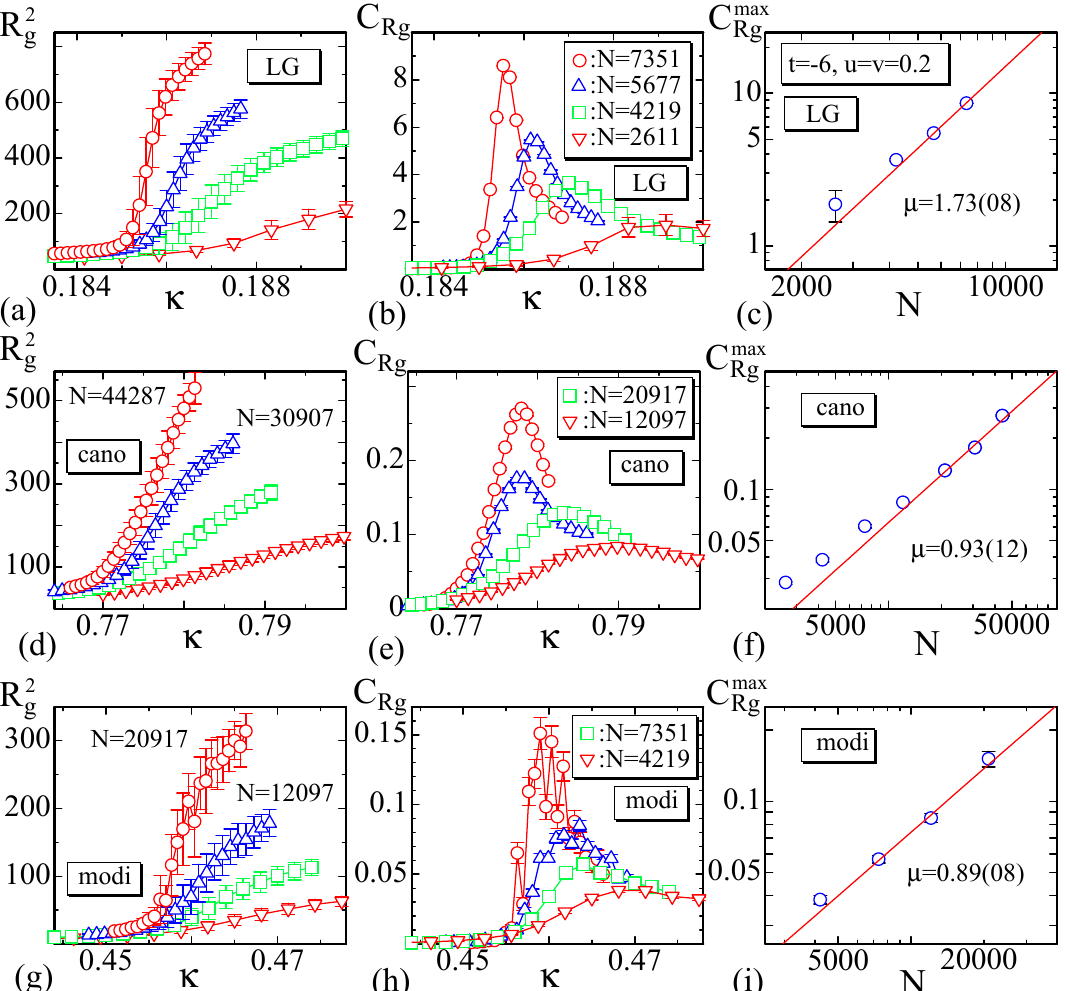
, and the log-log plot of the peak value C max g